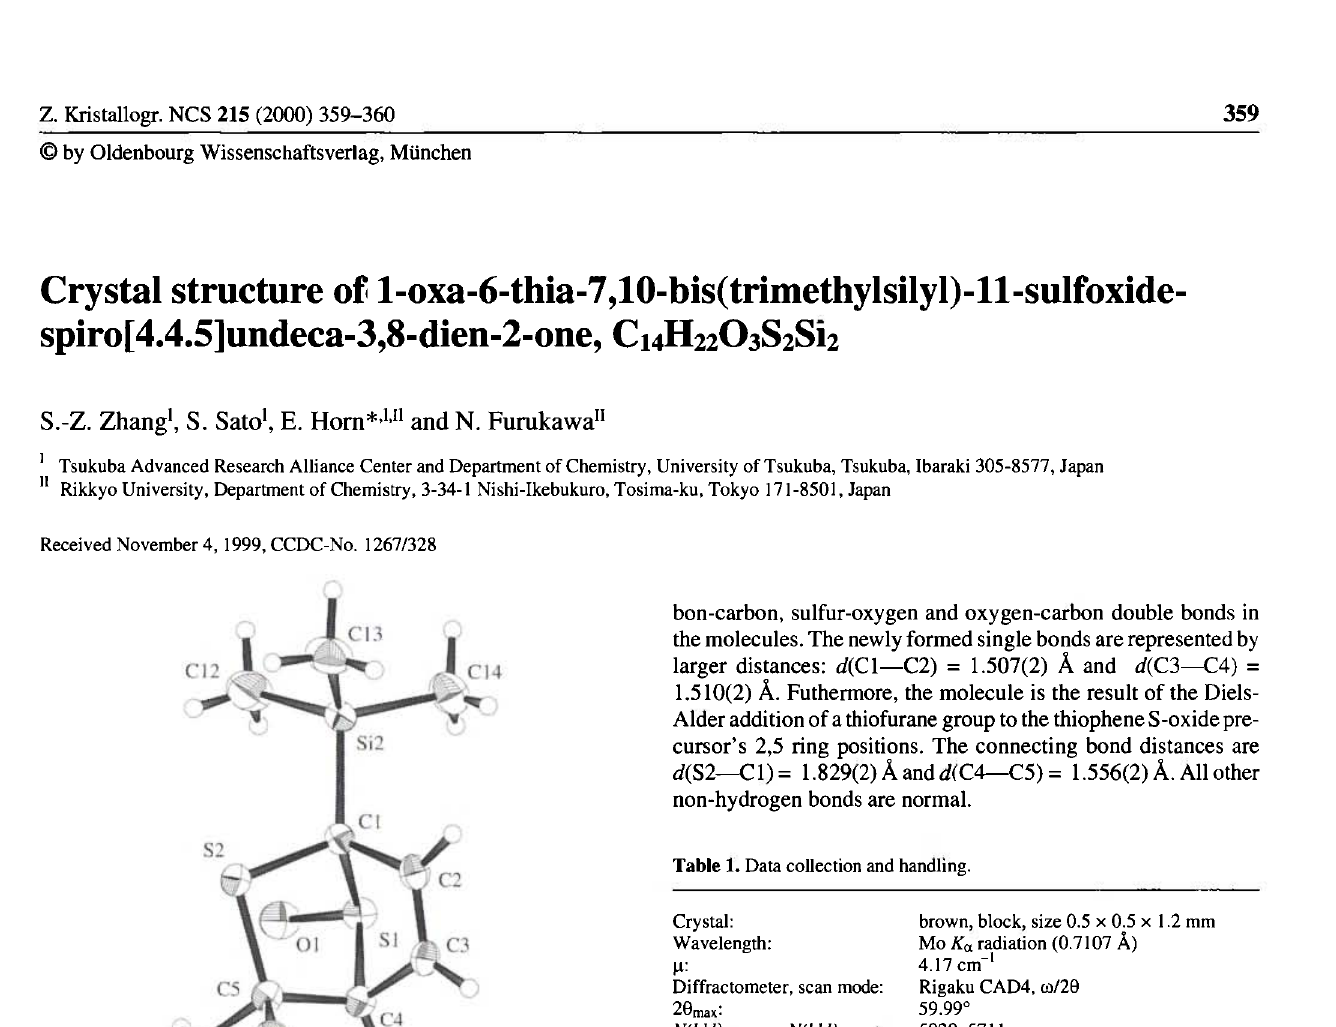
Table 2. Atomic coordinates and displacement parameters (in Ä 2